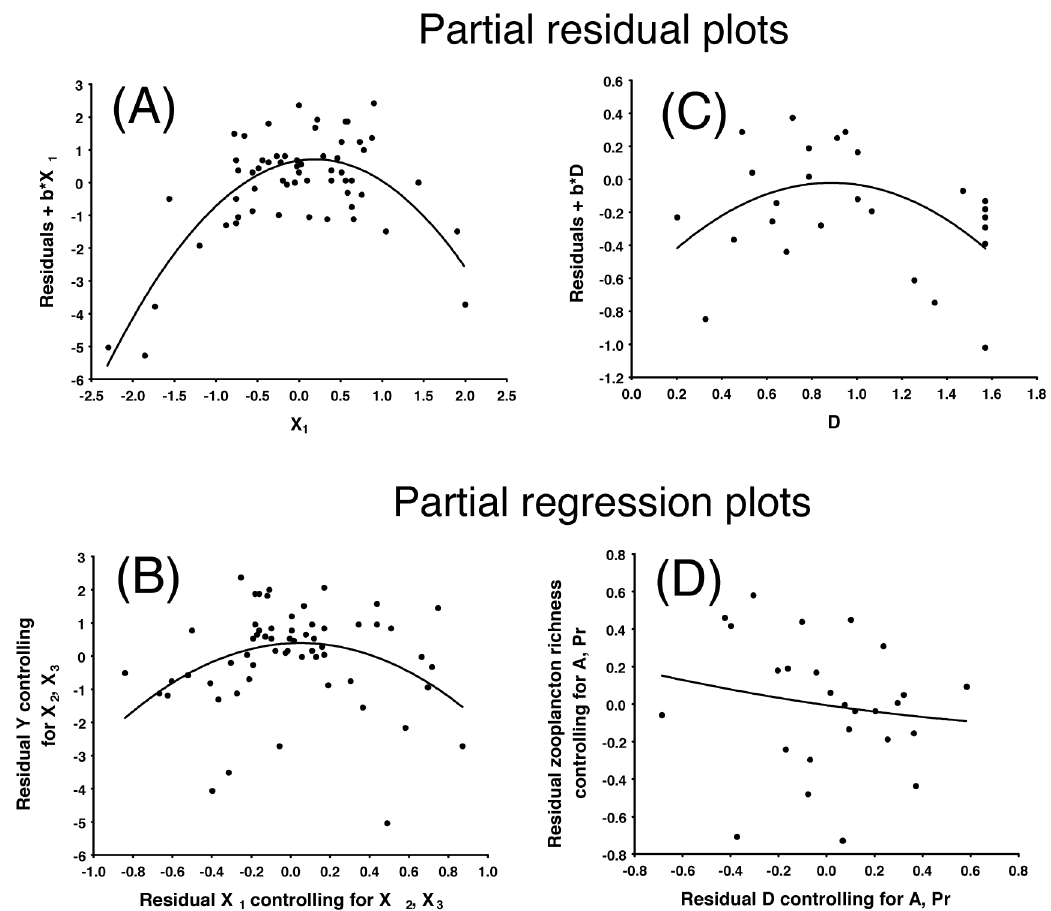
Fig. 2. Non-linear patterns in multiple regression are detected more efficiently in partial residual plots than in partial regression plots. (A) partial residual plot of X A, log-transformed lake area; Pr, log-transformed primary productivity; D is arcsine-square-root transformed proportion of watershed developed. (D) partial regression plot for the same variable. Quadratic polynomials have been fitted to facilitate the assessment of the curvature. Note how partial residual plots show a true underlying curvilinear pattern more efficiently by making it more pronounced and how partial residual plots fail to show a pattern in a real-case scenario (plot